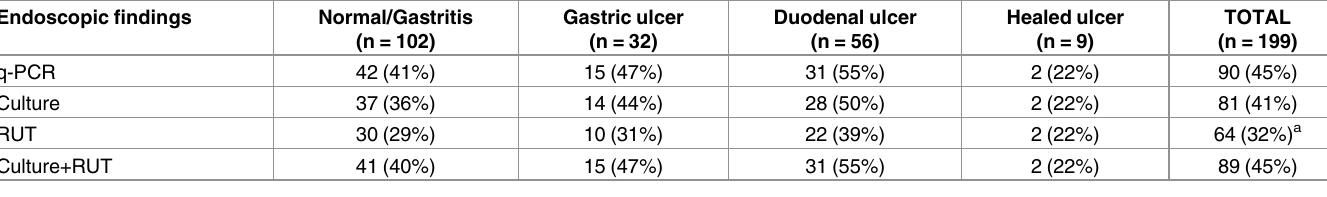
Table 3. H . pylori results by different diagnostic test according to result of endoscopy.